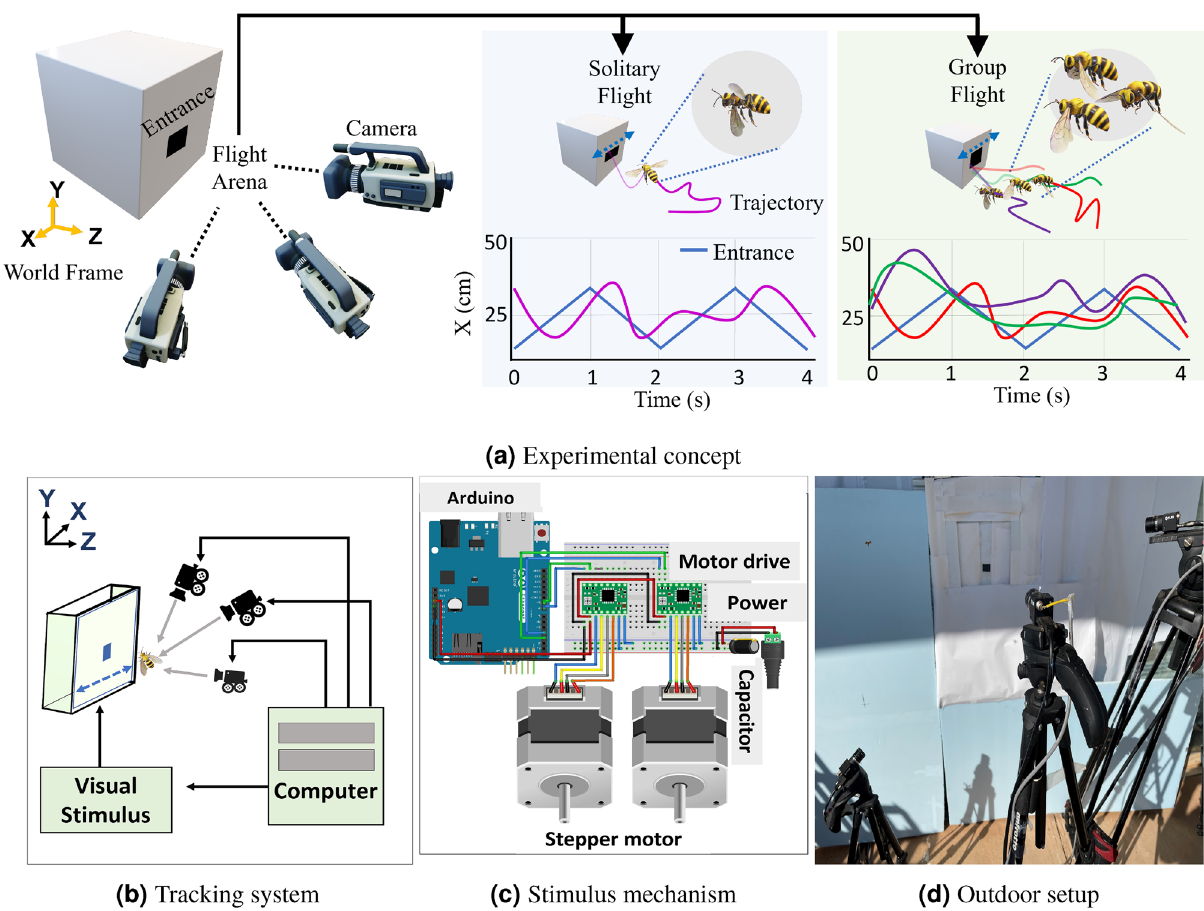
Figure 1. ( a ) Experimental design consists of three camera based tracking system which record the trajectories of insects approaching to the entrance. Two types of bees’ data were segmented: solitary flight (light blue shading) and group flight (light green shading). X coordinates of entrance (blue) and insect from their 3D trajectories are considered as input and output for system identification approach, respectively. A three camera-based tracking system ( b ) was used to record flight paths of multiple insects (and stimulus) tracking a moving hive entrance actuated by an Arduino micro-controller and stepper motors ( c ), mounted in an outdoor environment ( d